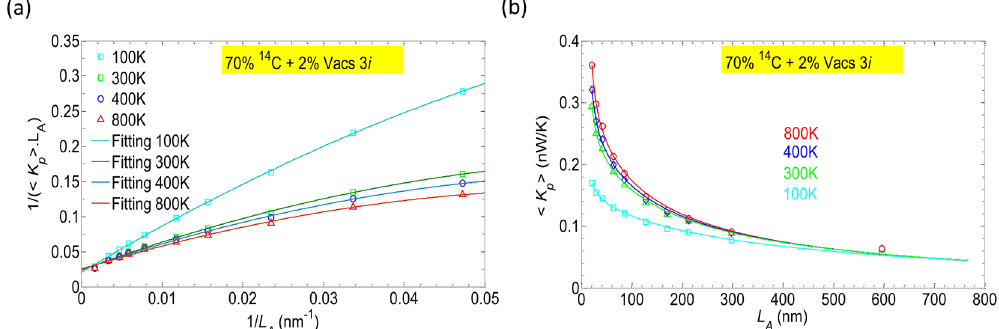
Figure 7. ( a ) The inverse of the thermal conductivity as a function of 1/ L A . ( b ) Average phonon conductance as a function of the active length L A . In the both panels, symbols are numerical results and the solid lines are fitting/analytical results. In Figure ( b ), the filled symbols are additional numerical results for comparison with results predicted by solid lines. Data provided for M = 5 nanoribbons.